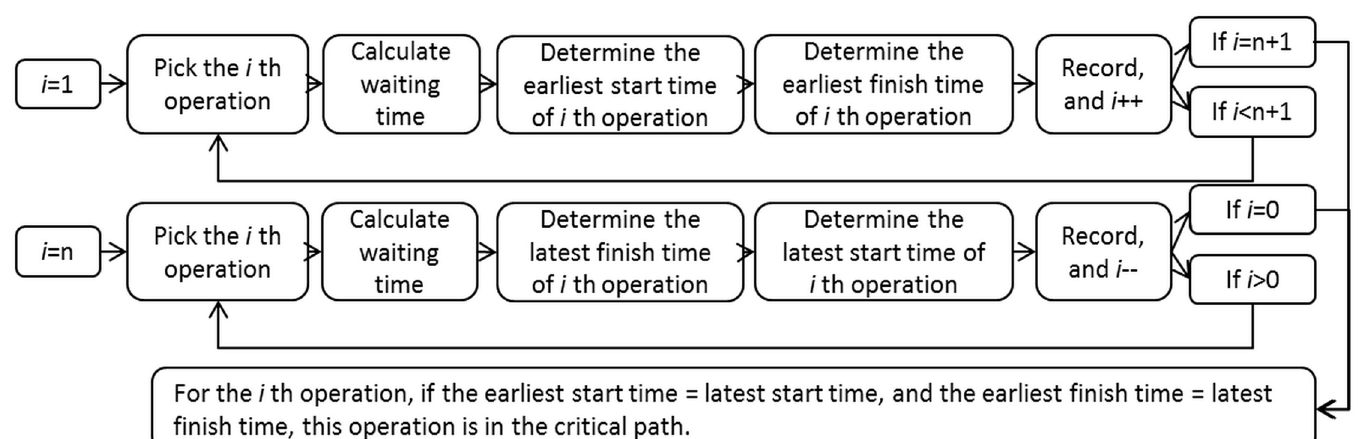
Fig 3. Flow chart of the conventional algorithm of determining the critical path.